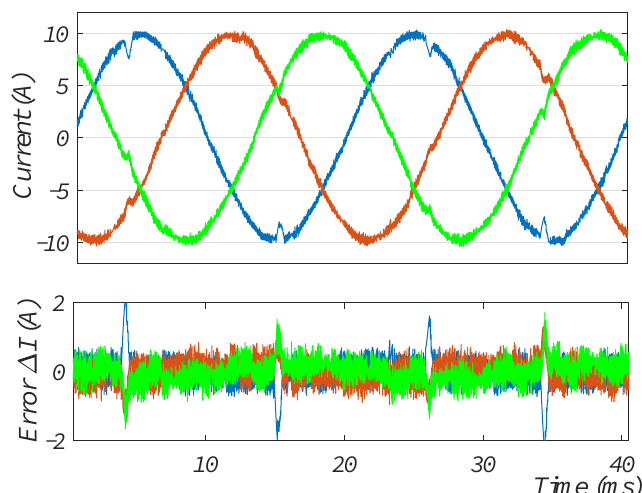
Figure 6. Simulation results of MPC without identification: Output current for specified resistive load and filter inductance.